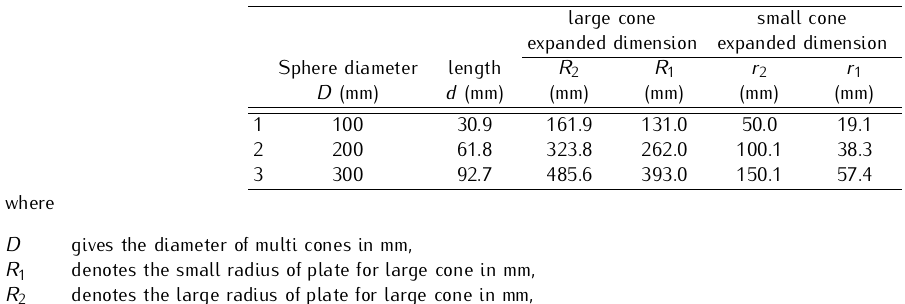
Table 4. Dimensions and sizes of expanded models for large and small cones.